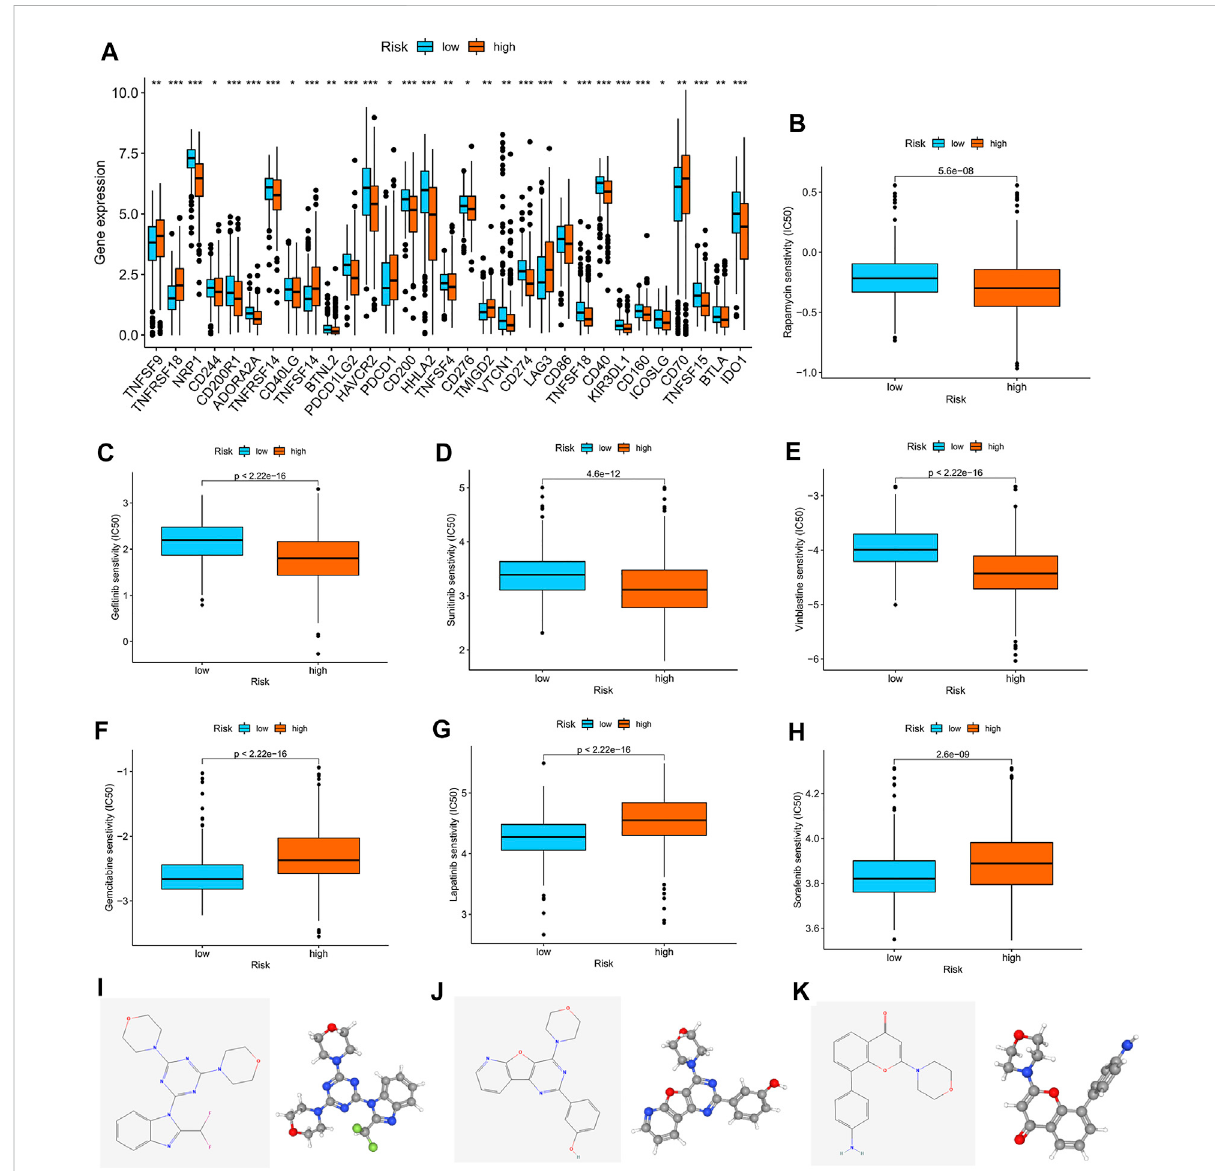
FIGURE 7 Correlation analysis between the m7G score and therapeutic drugs. (A) Expression pro fi les of checkpoints in the high- and low-risk groups. (B – H) Correlation analysis between the m7G score and IC 50 of rapamycin, ge fi tinib, sunitinib, vinblastine, gemcitabine, lapatinib, and sorafenib. The 2D and 3D structures of (I) ZSTK-474, (J) PI-103, and (K)